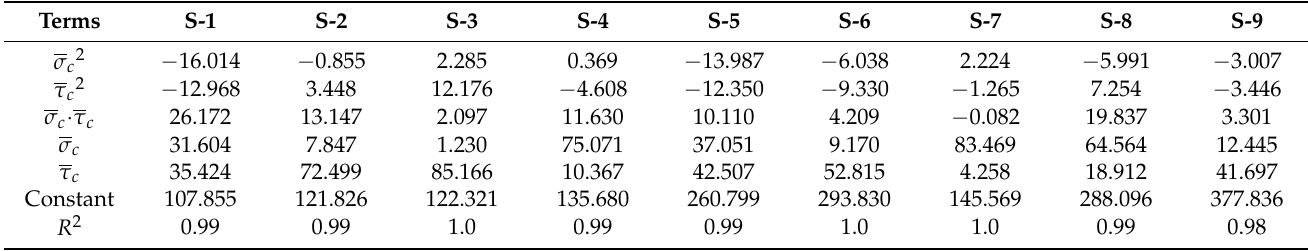
Table 10. Response surface equation of peak strength.